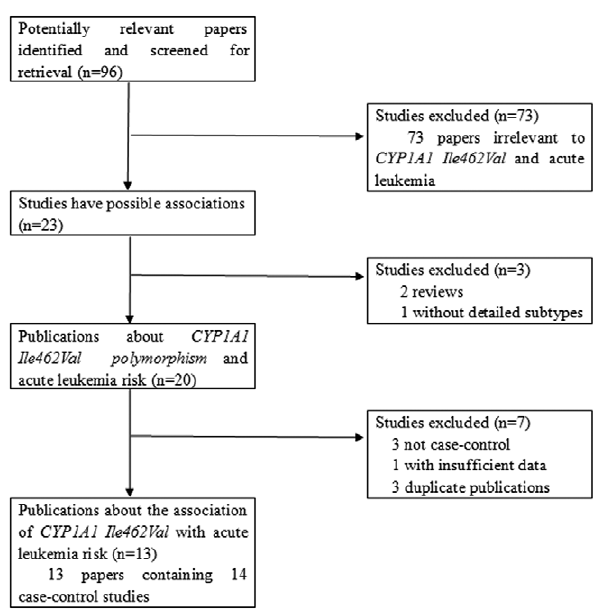
Figure 1. The flow diagram of included/excluded studies.